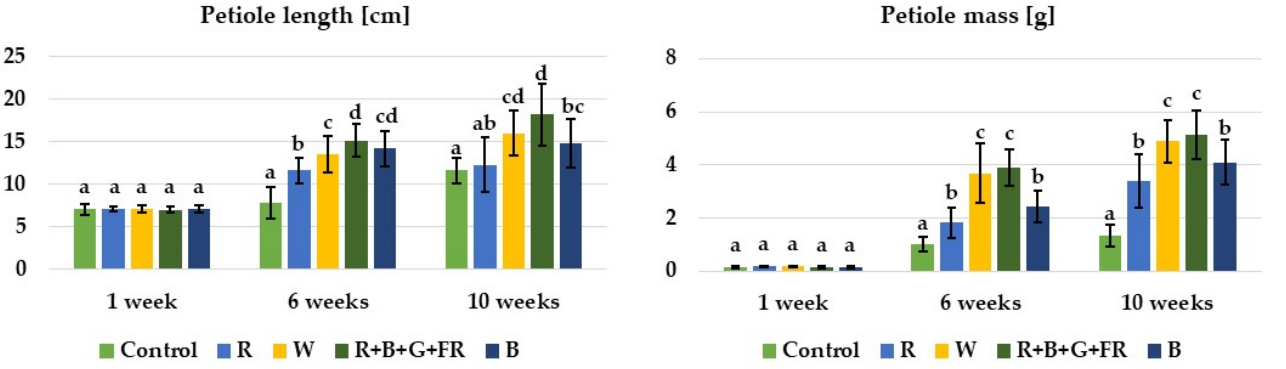
Figure 4. The e ff ect of light quality on the growth rate responses of Rheum rhaponticum ‘Raspberry’ after 1, 6, and 10 weeks of growth in Floragard substrate and under di ff erent LED light treatments (control—natural light, R—red, W—white, B—blue, R+B+G+FR—far red). Bars represent means ± SE. According to Duncan’s test ( p = 0.05), the mean values indicated with the same letter within each term do not differ